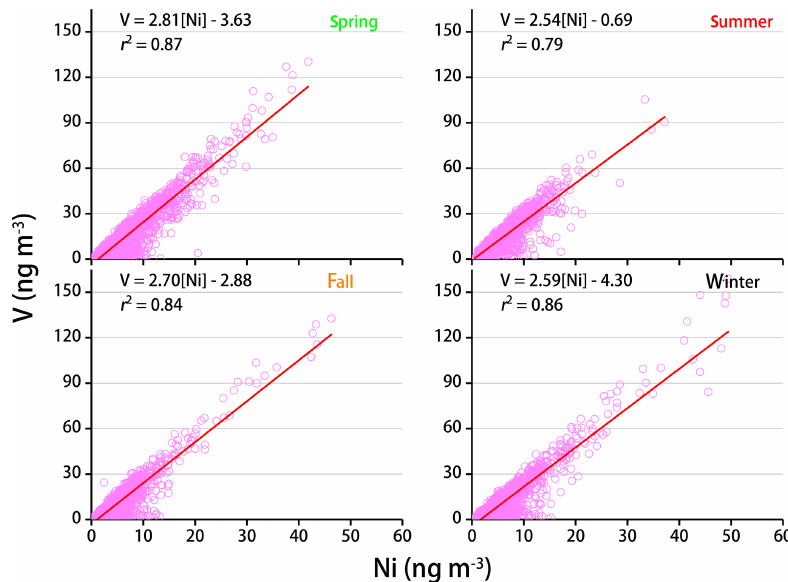
Figure 5. Linear correlation analysis between Ni ( x axis) and V ( y axis) in Shanghai during the four seasons.